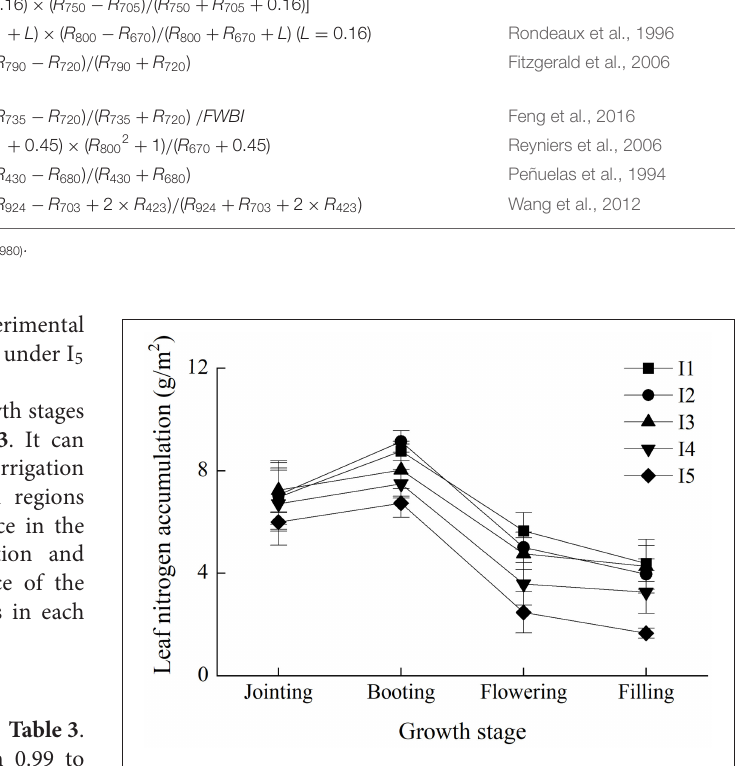
FIGURE 2 | Change trends of the leaf nitrogen accumulation over growth progress under different experimental treatments in winter wheat. I 1 represents four irrigations at jointing, booting, flowering, and filling stage. I 2 represents three irrigations at jointing, booting, and filling stage. I 3 represents two irrigations at jointing and flowering stage. I 4 represents two irrigations at jointing and filling stage. I 5 represents the treatment without